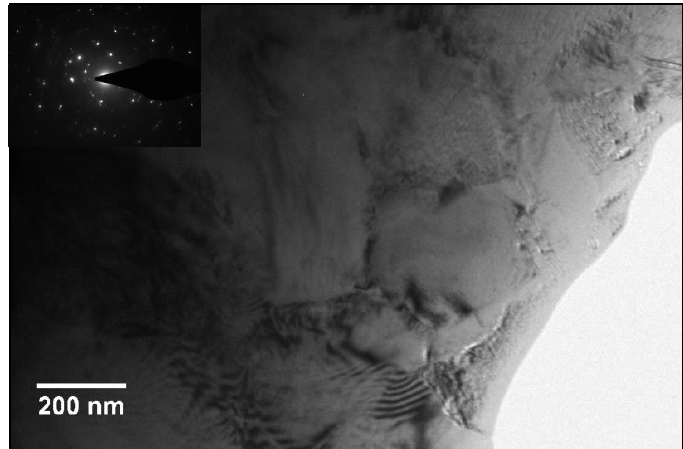
Figure 2. Transmission electron micrograph of melt spun Al-Mn-C after conversion to τ (inset: Selected area electron diffraction pattern of the